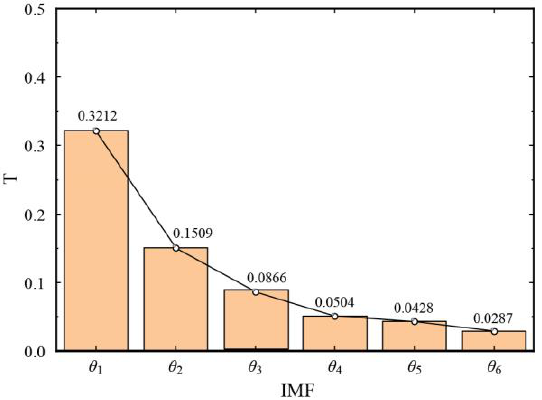
Figure 7. The T value of the coefficient to be reconstructed of the first 6 components IMF.